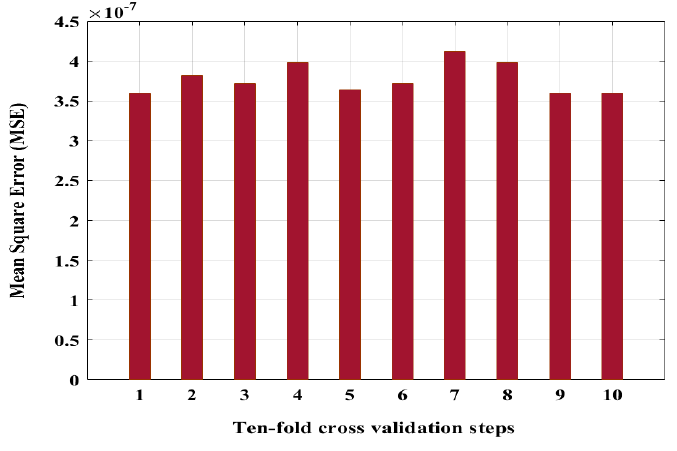
Figure 4. Ten-fold cross-validation MSE.